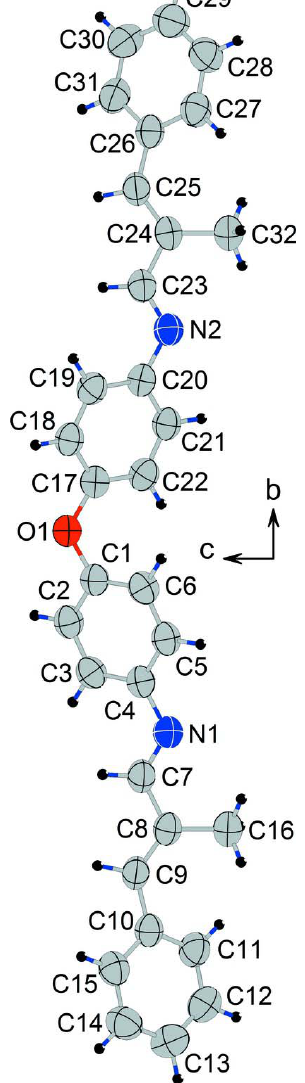
Figure 1 The molecule of (I) viewed along a with atom-labeling scheme. Displacement ellipsoids are drawn at the 50% probability